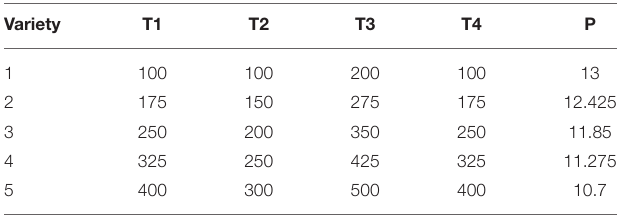
TABLE 1 | Thermal times and critical photoperiods used for the different varieties ( ◦ C).